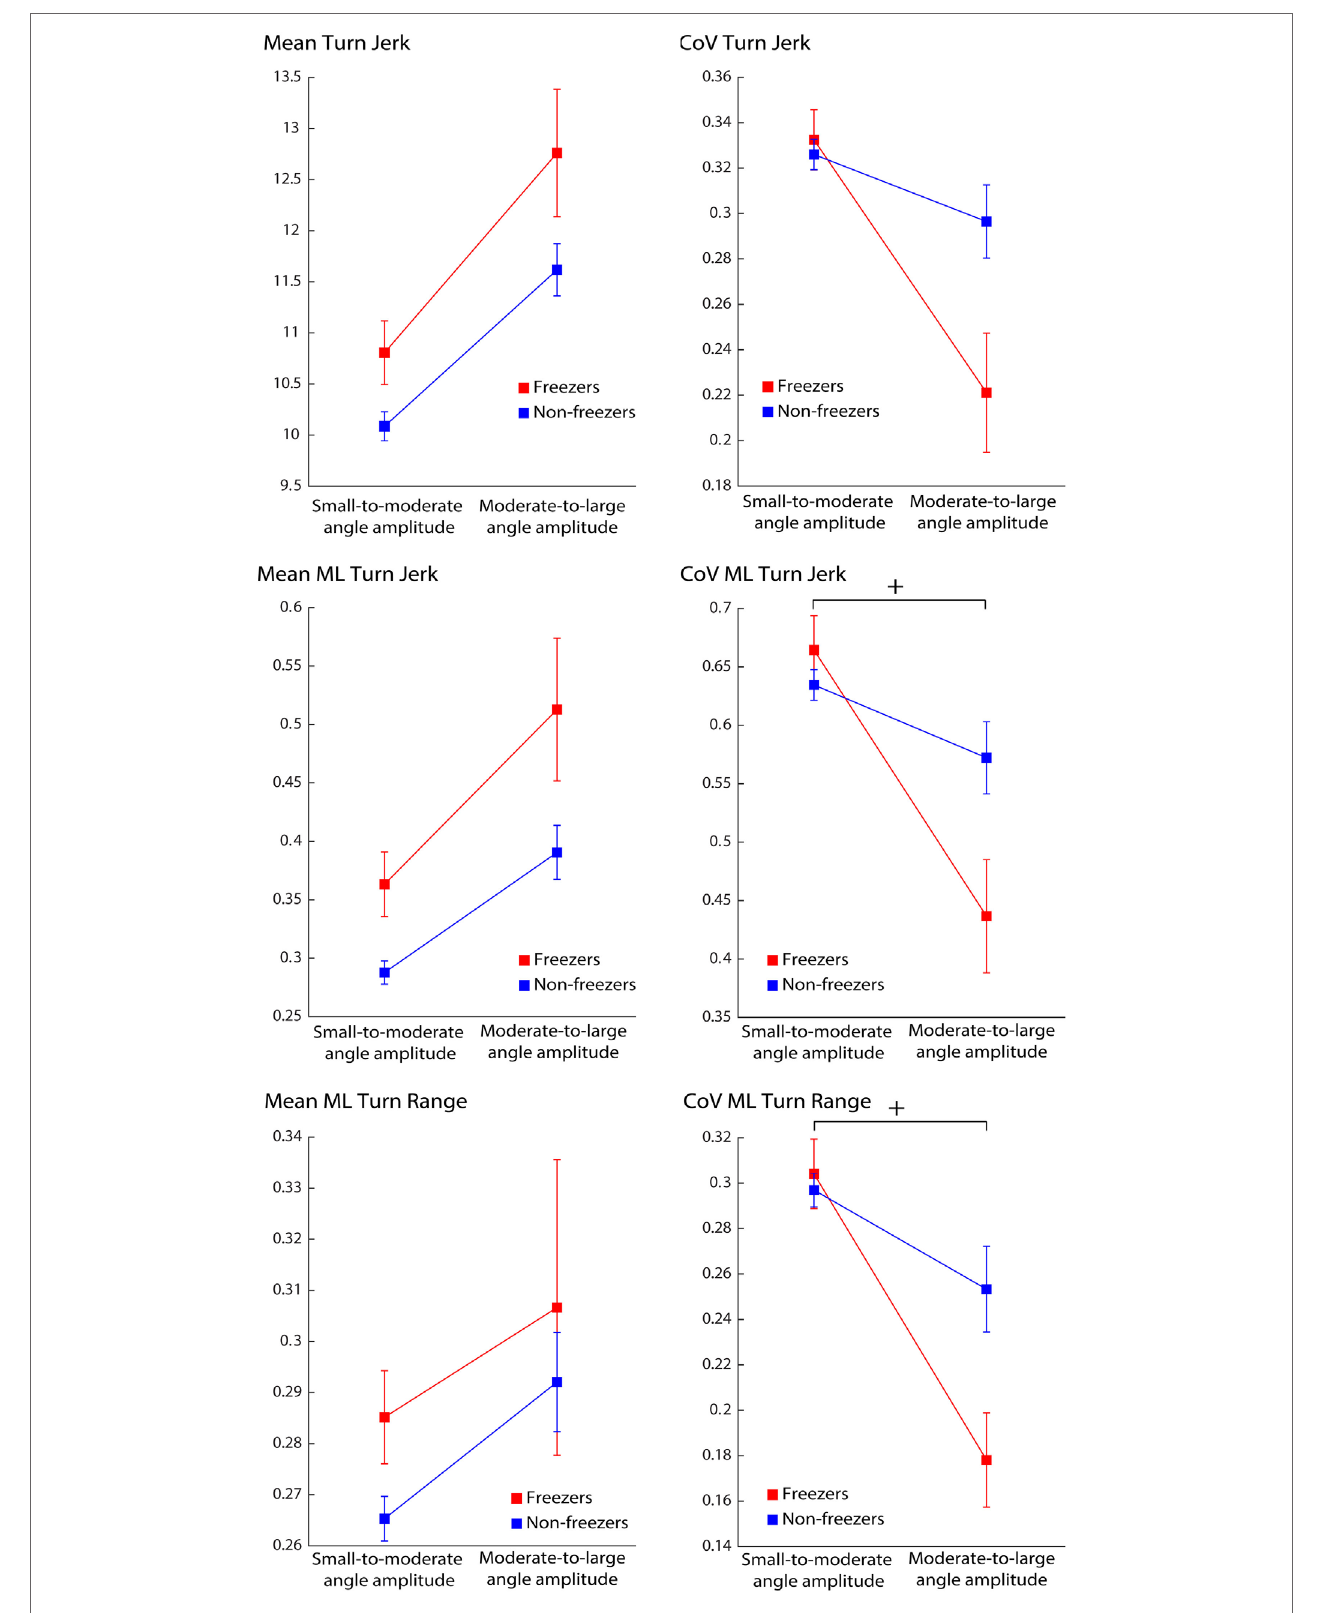
FigUre 2 | Effect of turning angle amplitude in Parkinson’s disease freezers and non-freezers on quality of turns over 72 h. Legend: + significant interaction effect, p <